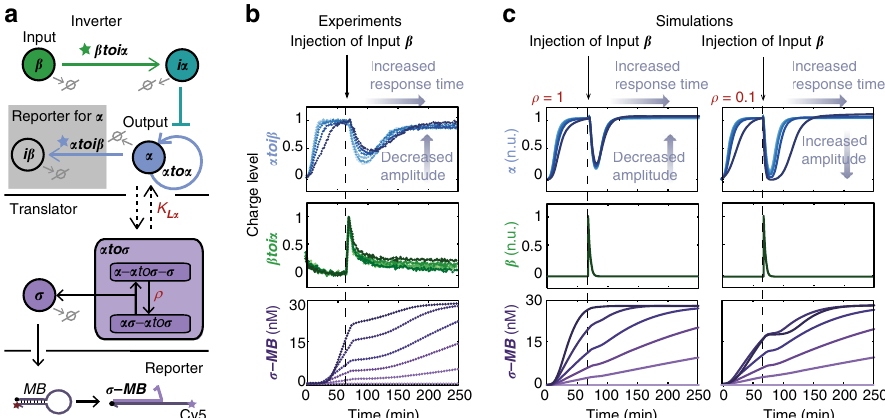
Fig. 3 Coupling of the translator module to an upstream INVERTER network. a Schematic illustration of the translator module coupled to a PEN-based INVERTER network. Multiplex monitoring of the dynamics of the network is performed using endogenous template β toi α and an exogenous template α toi β which are 3 ′ -end fl uorescently labeled with DY530 and FAM, respectively, while the output strand σ of the translator module is measured via a MB bearing a fl uorophore-quencher pair. b Results of the experiments that were conducted for 0, 2, 5, 10, 20, and 40 nM (light to dark) of translator template α to σ in the presence of 7 nM α to α , 20 nM of β toi α and α toi β , 30 nM MB, 10 U mL − 1 Bst 2.0 WarmStart DNA polymerase, 25 U mL − 1 Nt. bstNBI, and 50 nM ttRecJ. The INVERTER is activated by addition of 0.5 nM α which is initially ampli fi ed until it reaches steady-state in which production by polymerase and nickase and degradation due to exonuclease are balanced. Applying a pulse of 30 nM of input β at this point initiates the production of i α , which inhibits autocatalytic production of output α . As input strand β gets degraded the system returns its pre-stimulus steady-state. Hence, the INVERTER network shows a pulse response after injection of input β , which can be characterized by its amplitude and response time which is the time needed to recover to the pre-stimulus steady-state. The charge level is the normalized fl uorescence of the signal of DY530 and FAM fl uorophores, which is 0 in the absence of template ’ s input primer and 1 at the maximal or steady-state value of primer β and α , respectively. The fl uorescence of Cy5 fl uorophore was converted to concentration of DNA strand σ using a standard curve (Supplementary Fig. 17). c Results of simulations using the heuristic model with the same concentrations of translator template as used during the experiments in b and for different values of ρ . The traces were converted to normalized units (n.u.) by normalizing α to the steady-state concentration and normalizing β to its maximum